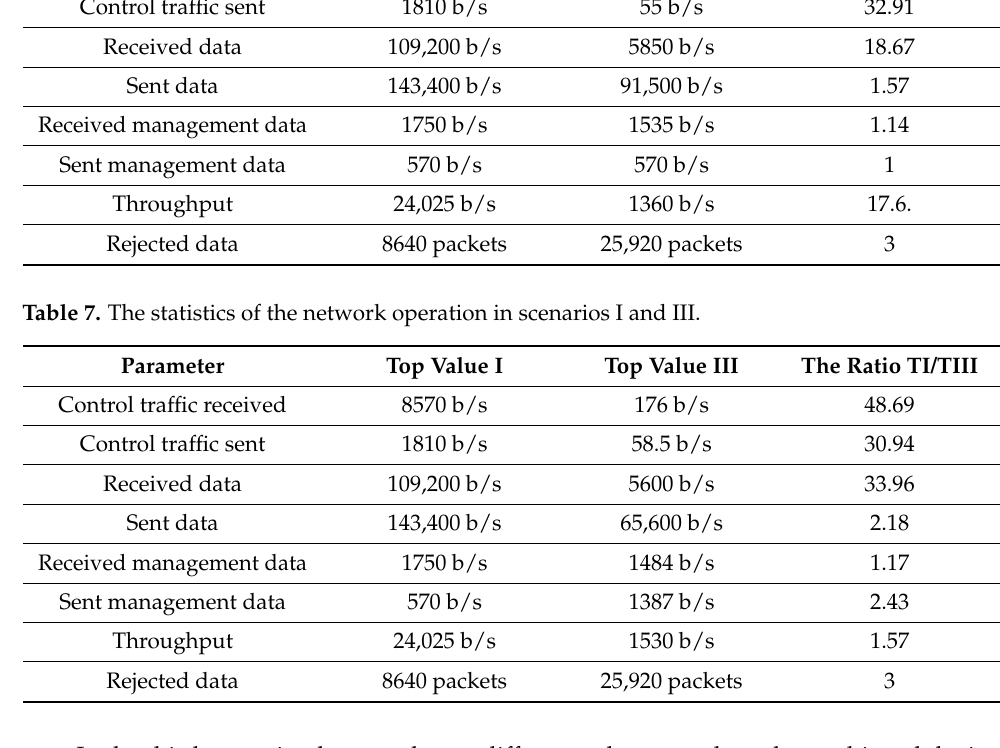
Table 7. The statistics of the network operation in scenarios I and III.